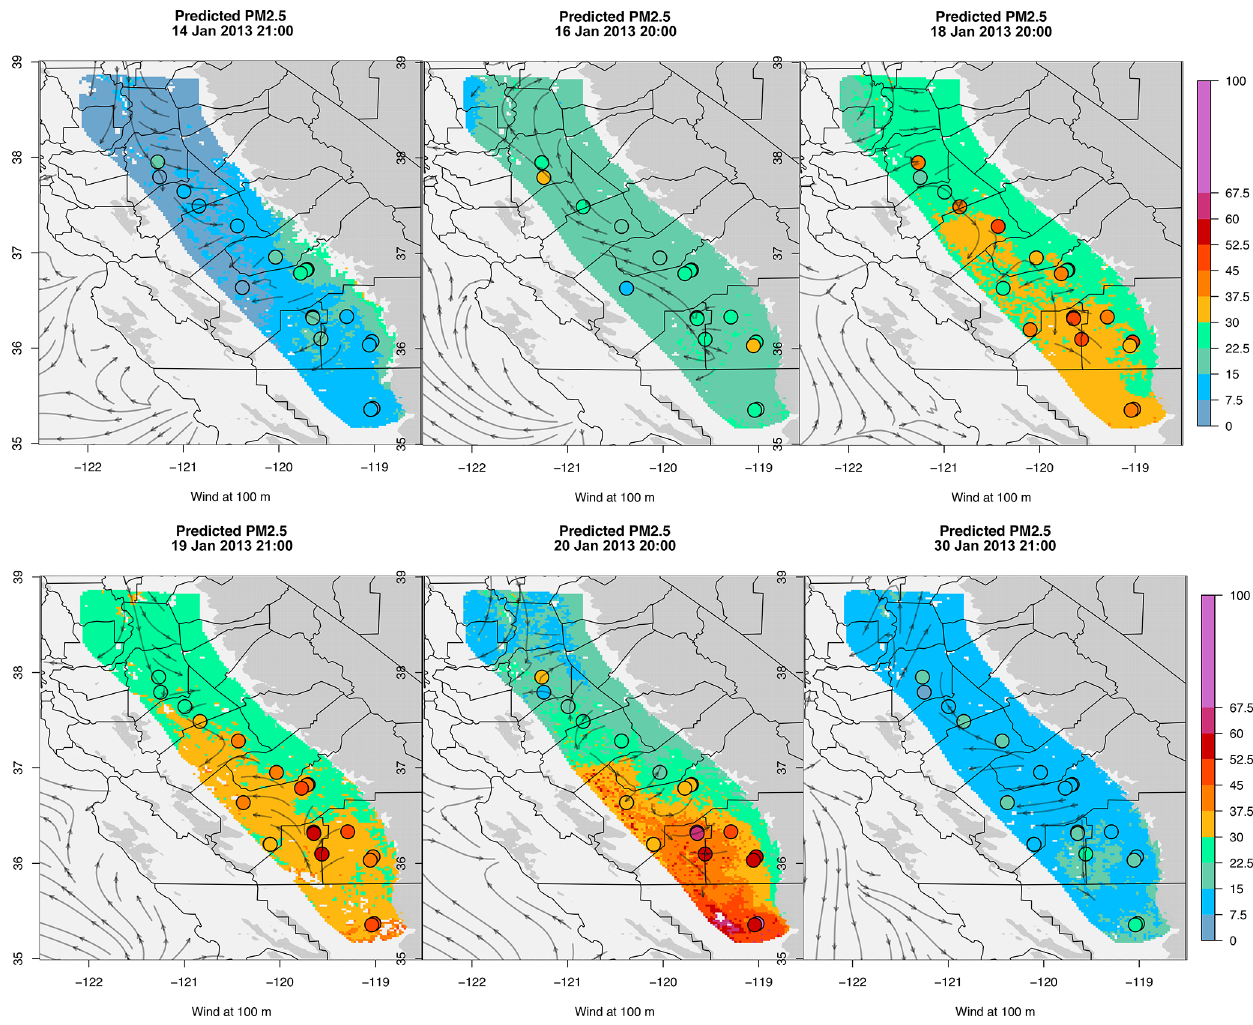
Figure 6. Estimated surface PM 2 . 5 at 1km indicated overpass times for the first wintertime episode in the San Joaquin Valley. Winds at 360ma.g.l. are also shown. Estimated RMSE is 7µgm − 3 with a similar limit of detection. Filled circles show station PM 2 . 5 . In this episode, the E–W correction based on the full dataset appears inappropriate, lowering mapped estimates in the east valley. Error should decrease with improved understanding of geographic variability. The time stamp at the top of the image describes the date and time in UTC